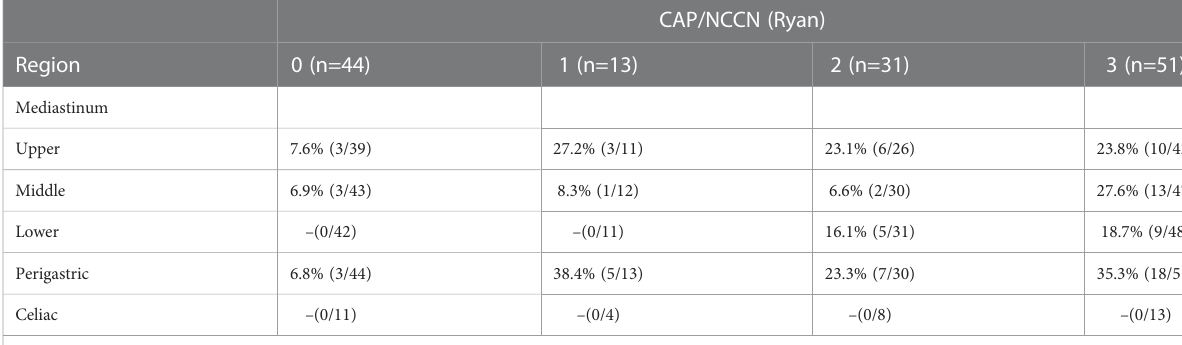
TABLE 6 Lymph Nodes Metastasis Rates of different regions After